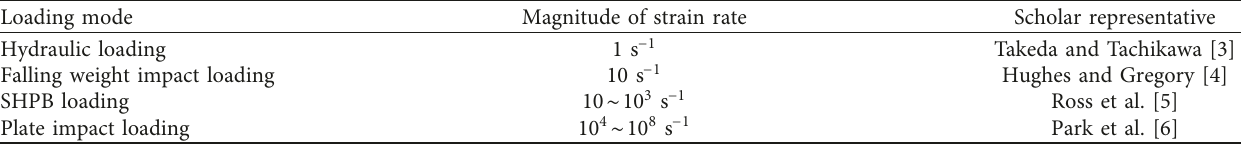
Table 1: Comparisons of the four